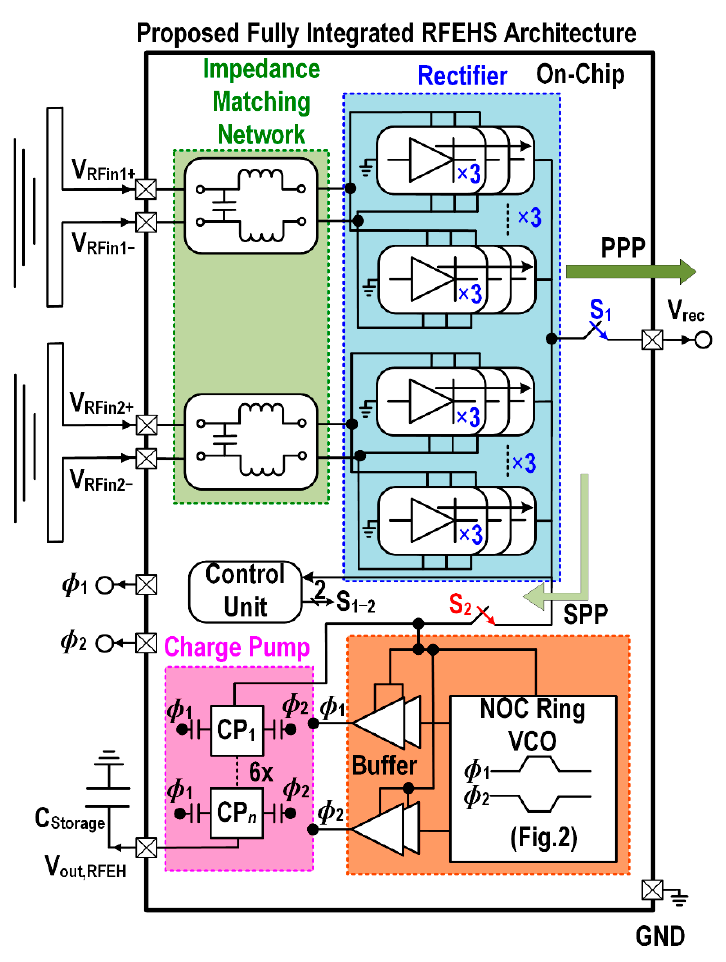
Figure 2. Block diagram of fully-integrated dual-input RF energy harvesting (RFEH) system.